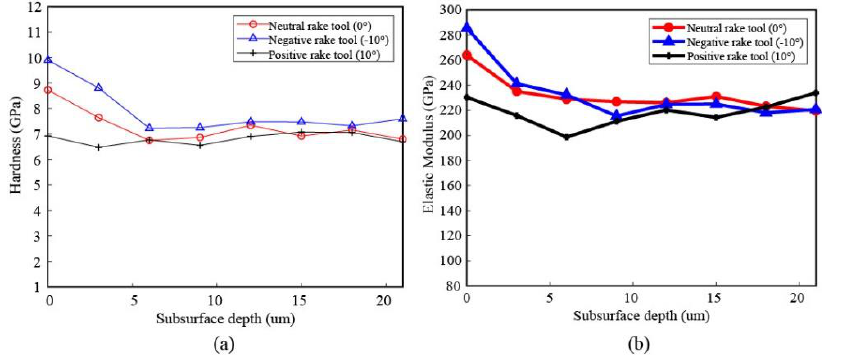
Figure 14. Nano-hardness and elastic modulus variation profile in the subsurface area of machined workpiece. ( a ) The measured hardness in subsurface areas of machined workpiece and ( b ) the corresponding elastic modulus in subsurface areas.